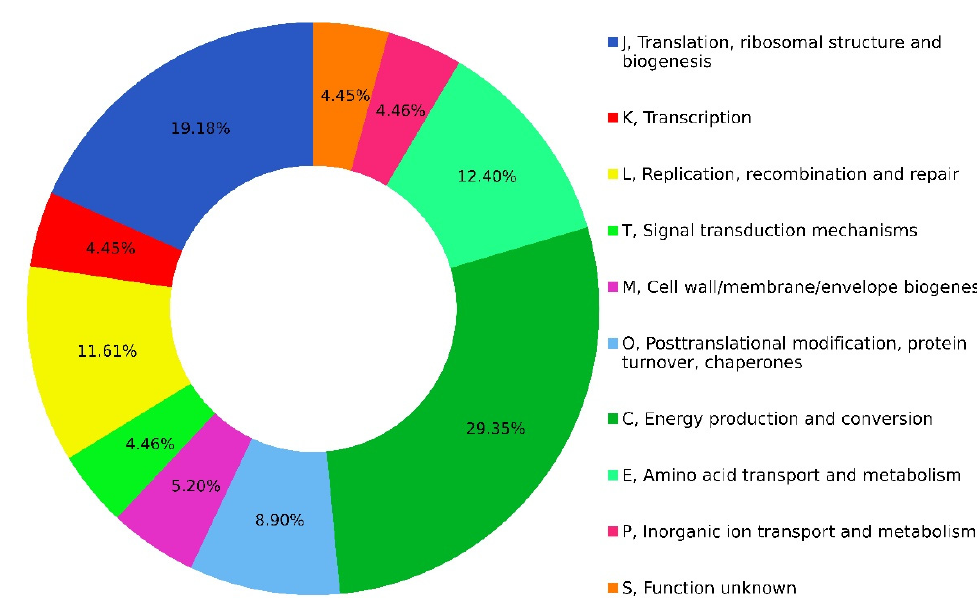
Figure 2. COG functional classification of genes belonging to the Xenorhabdus–Photorhabdus core genome. COG database annotation was used to classify the 348 members belonging to the core genome. The abundance of specific gene classes is shown.